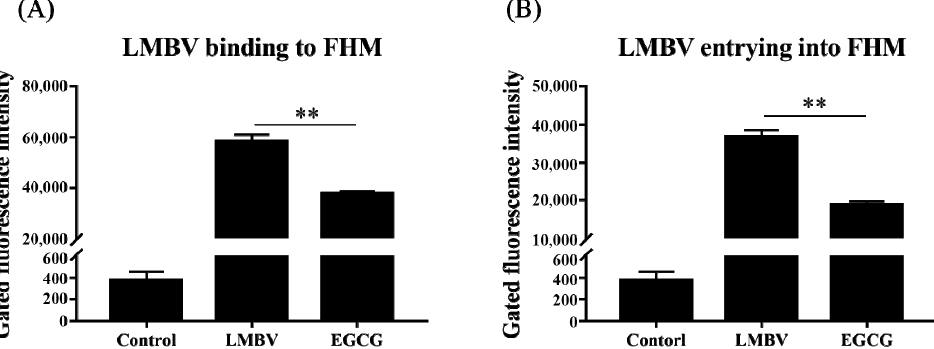
Figure 4. Antiviral ability of EGCG in the various stages of viral infection was analyzed by RT ‐ qPCR. ( A ) When EGCG was added to the host cells at the adsorption stage of LMBV, the expression of ICP46 was significantly inhibited. ( B ) When EGCG was added to the host cells at the invasion period of LMBV, the expression of ICP46 was significantly inhibited. ( C ) When LMBV had already entered the host cell, the addition of EGCG did not show a significant inhibitory effect on the expression of ICP46. ** indicates p < 0.01, NS indicates no significant difference.